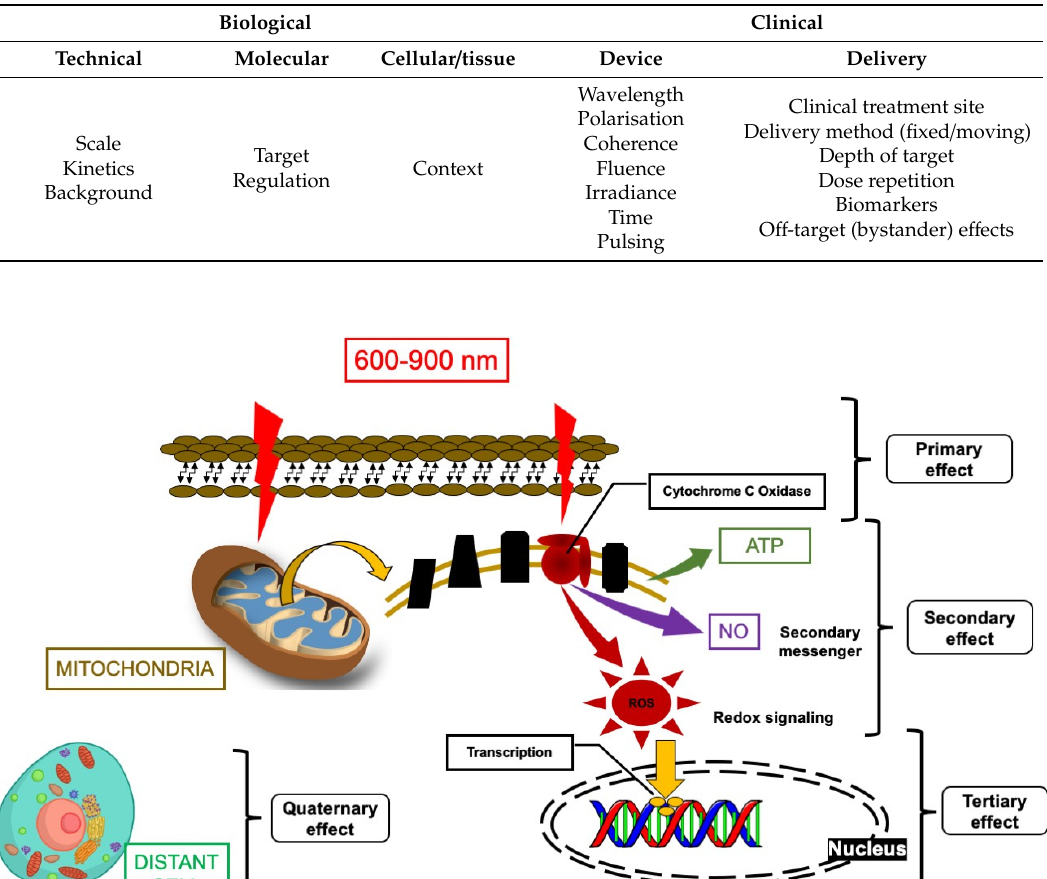
Table 1. The critical issues that require consideration in photobiomodulation therapy (PBMT) [9].